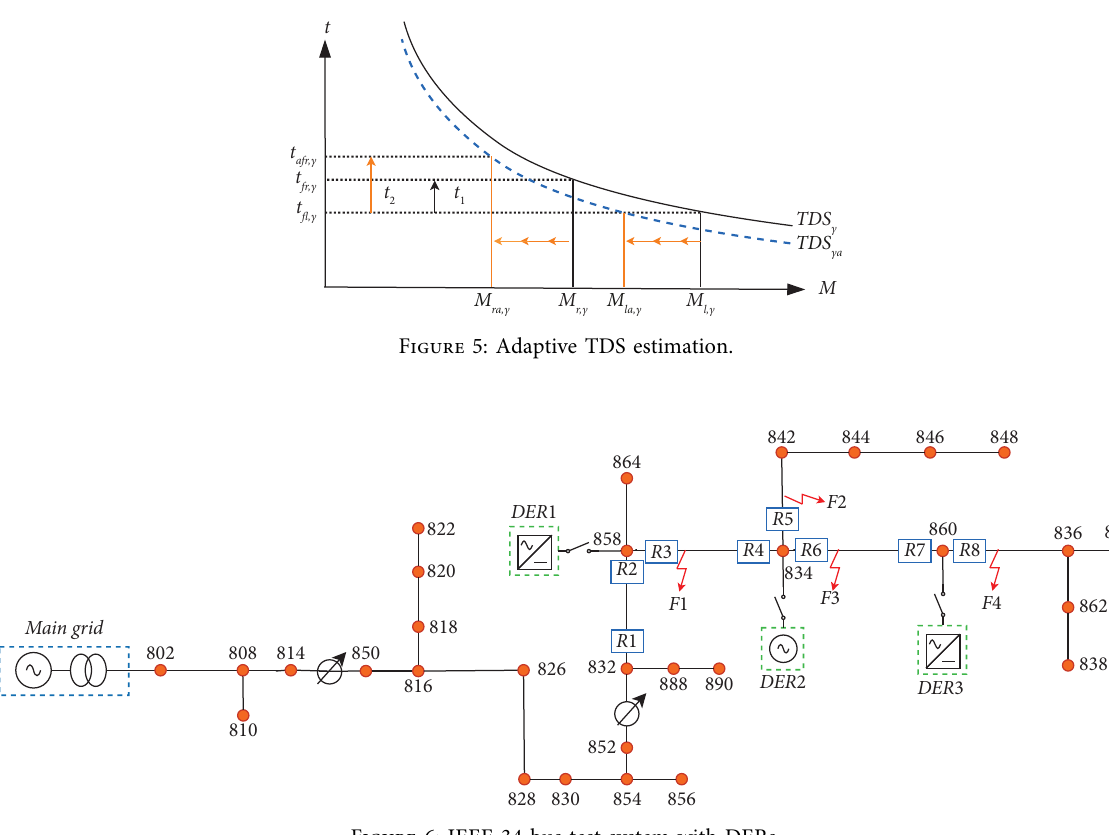
Figure 6: IEEE 34-bus test system with